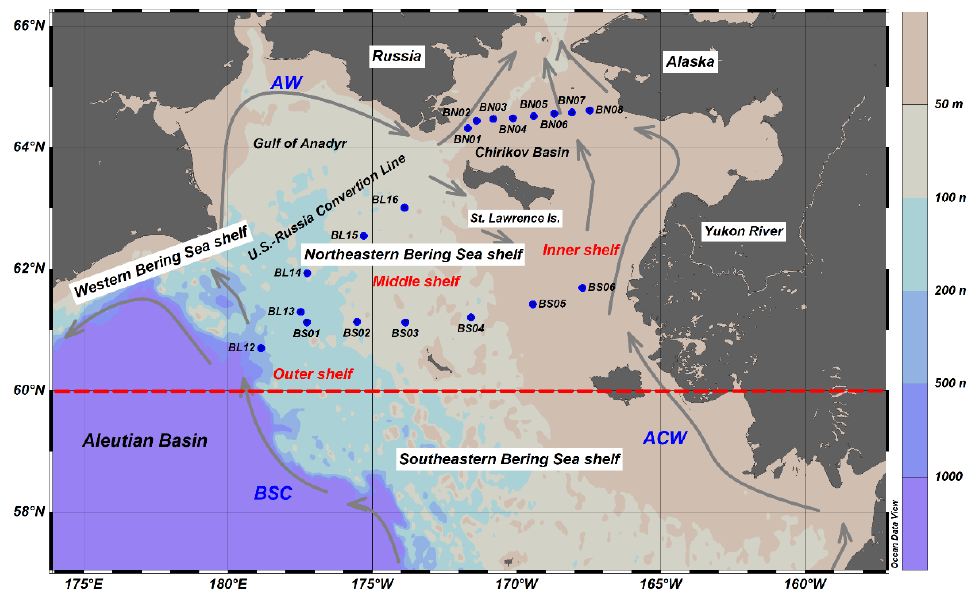
Figure 1. Map of sampling stations and water current in the eastern Bering Sea shelf. BSC—Bering Slope Current; AW—Anadyr Water; ACW—Alaska Coastal Water.